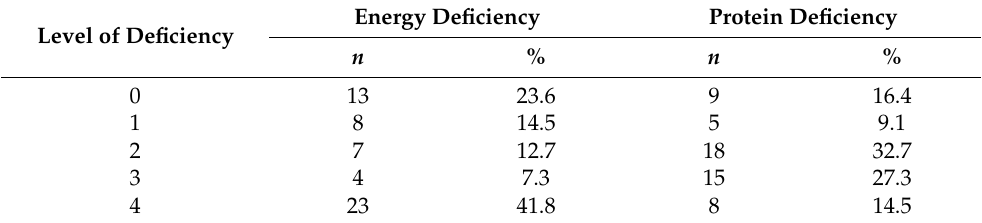
Table 2. Number and percentage of residents in energy and protein deficiency levels ( n = 55).